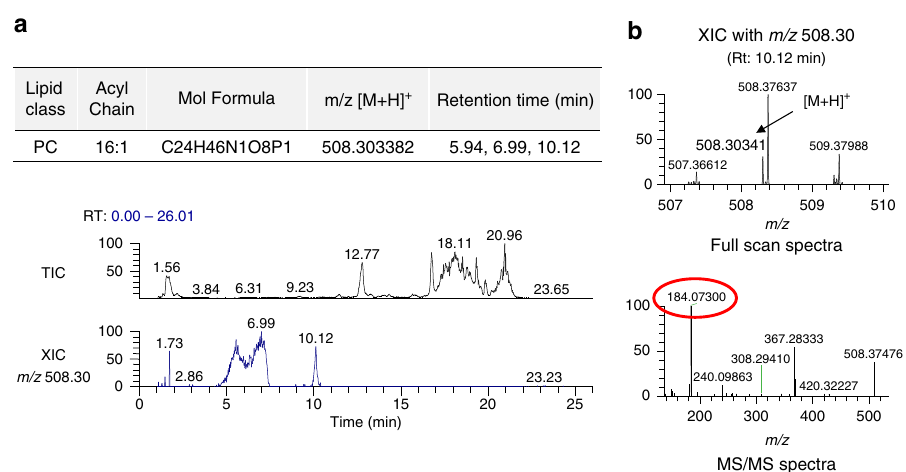
Fig. 5 Lipid analysis of Golgi membrane. a Representative liquid chromatography-mass spectrometric chromatograms of the Golgi lipid extract. Shown is the total ion chromatogram and the extracted ion chromatogram (XIC) of phosphatidylcholine (PC) (16:1) with m / z 508.30. Note that multiple peaks were detected in the XIC channel indicating that there are PC isomers with different acyl chain length. Peaks detected at 5.94, 6.99, and 10.12 min for m / z 508.30 are consistent with PC having different acyl chain length combinations of 10:0/6:1, 8:0/8:1, or 10:1/6:0. b Representative precursor and product ion spectra of XIC with m / z 508.30. The precursor ions are assigned with mass error <3 ppm. Characteristic fragment at m / z 184.07 (representing choline phosphate) further con fi rms the identity of